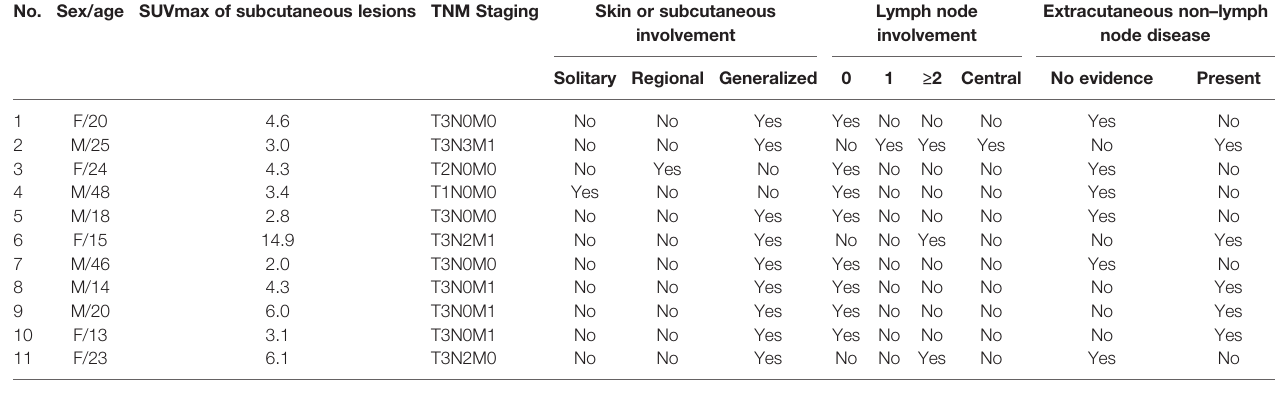
TABLE 3 | The simpli fi ed staging of subcutaneous panniculitis-like T-cell lymphoma by 18 F-FDG PET/CT according to TNM classi fi cation system. No. Sex/age SUVmax of subcutaneous lesions TNM Staging Skin or subcutaneous